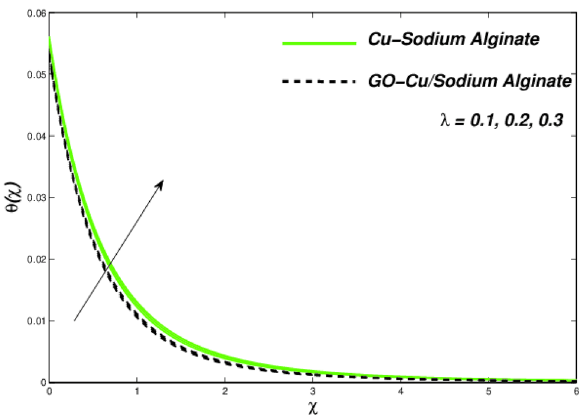
Figure 13. Changes in temperature subjected to (cid:31) .